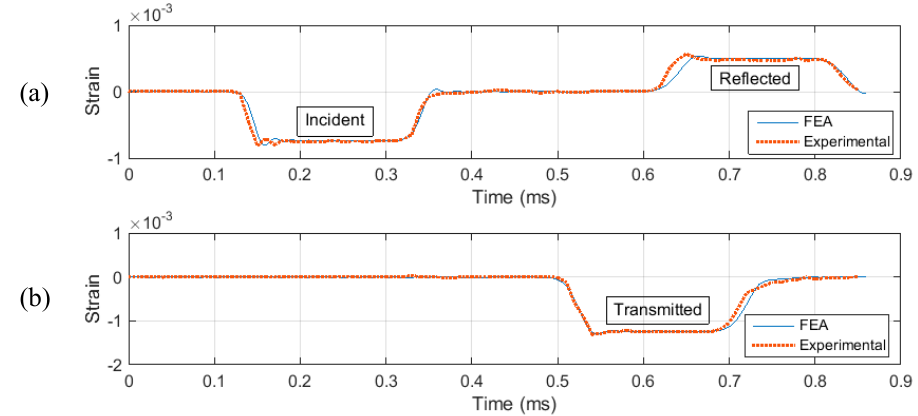
Figure 4. Exp. and Finite Element Model calibration, ( a ) In Incident Bar ( b ) In Transmission Bar